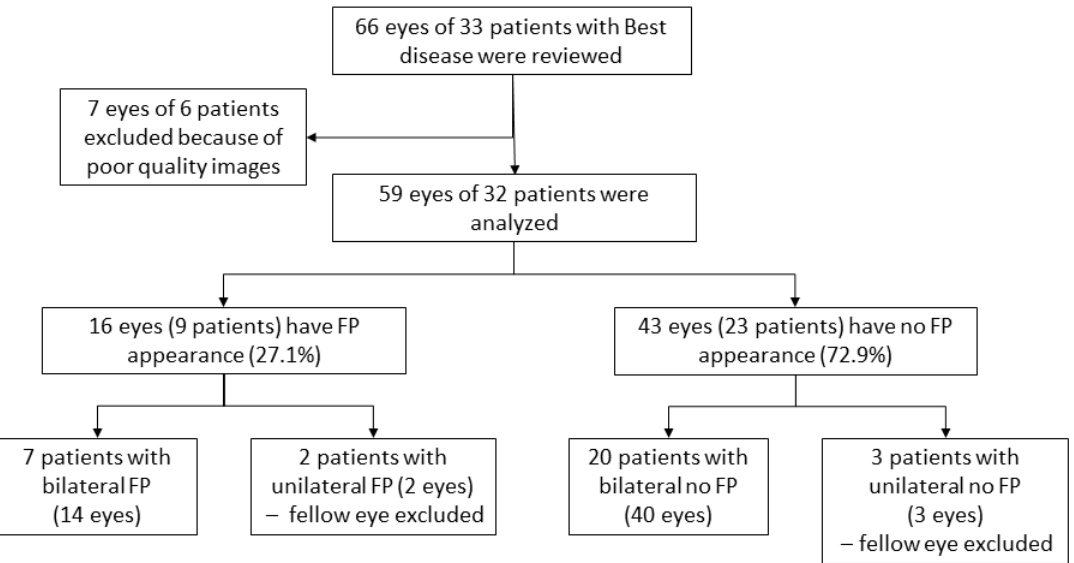
Figure 1. Flow-chart of included patients with Best disease, divided by the aspect of the fovea (fovea plana (FP) or no FP).